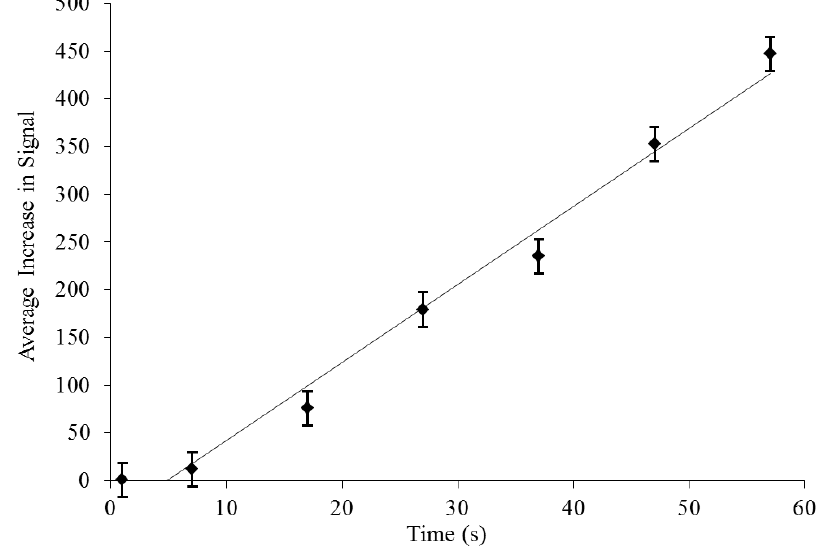
Figure 4. Dielectrophoretic bacterial concentration. While sample solution flows past the electrodes, the total donor fluorescence signal, summed over the entire image, from SYTO ® -9 labeled bacteria (no acceptor is present) increases linearly over time, measuring more than 400× (458.5 ± 18.2×, n = 6) the initial value after one minute flow at 100 µL/min.